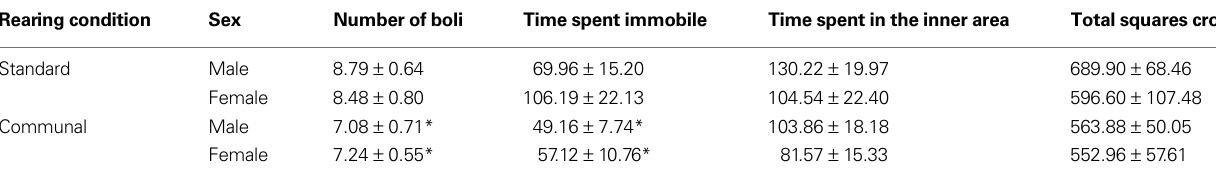
*Signifi cant difference in communal compared to standard reared, p < 0.05.